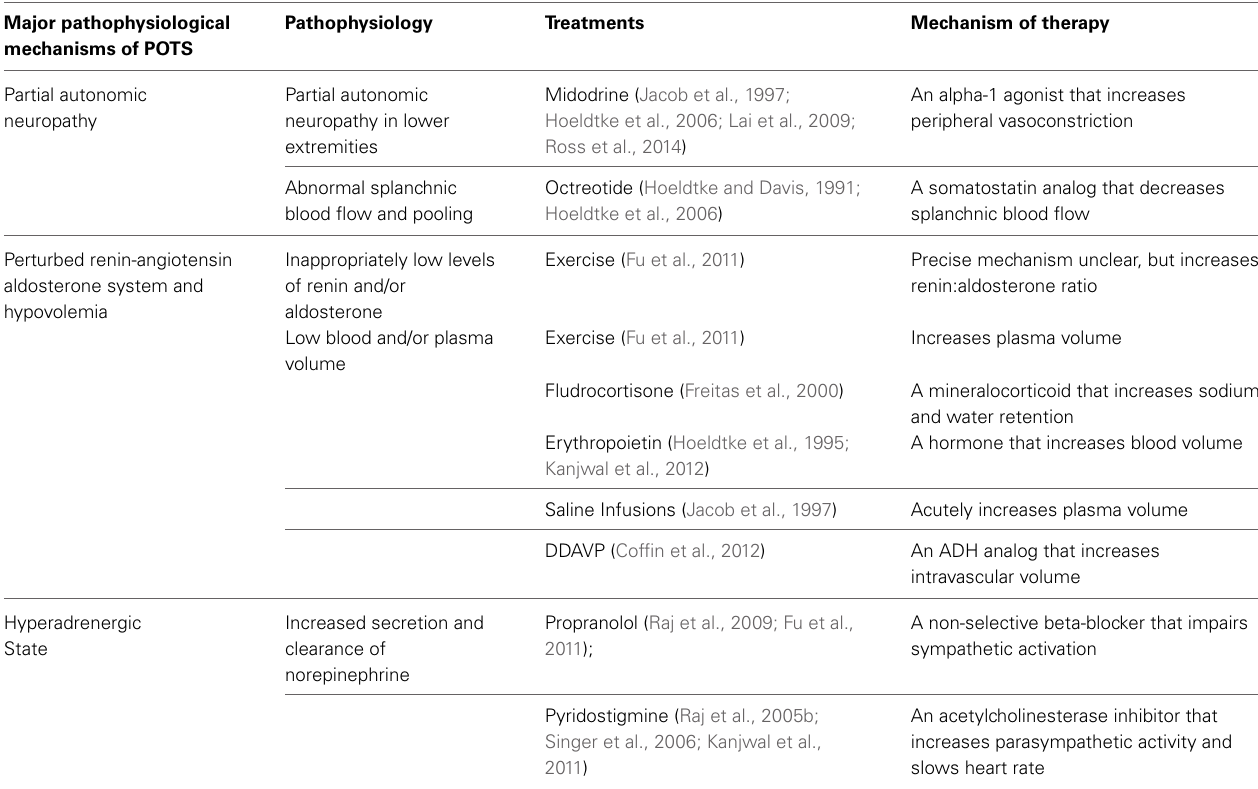
Table 1 | Some pathophysiological mechanisms of POTS and related